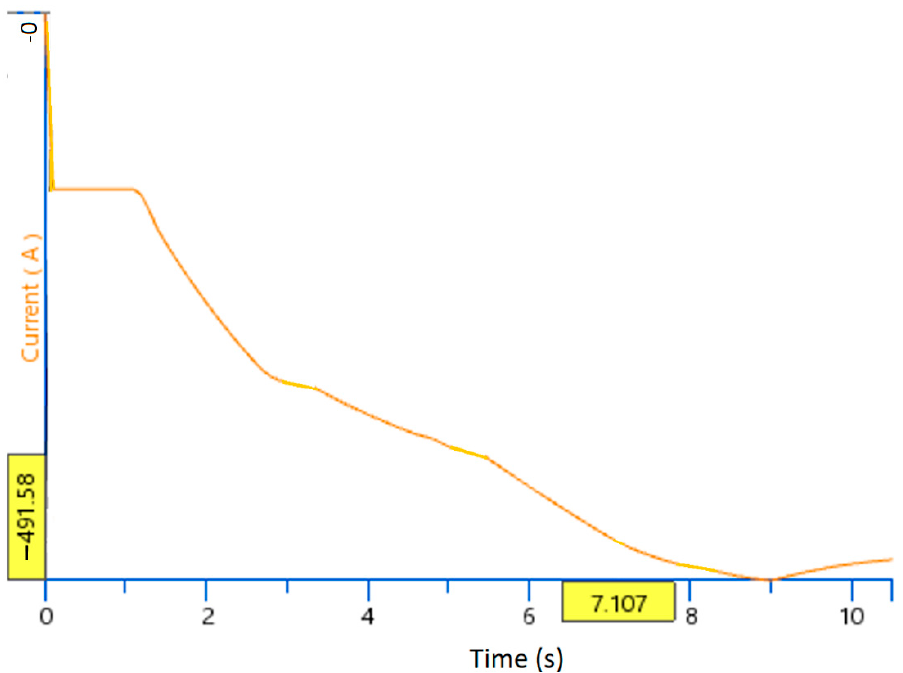
10 of 20 Table 3. Discharge current of the battery pack during 0–200 km/h acceleration simulation test.